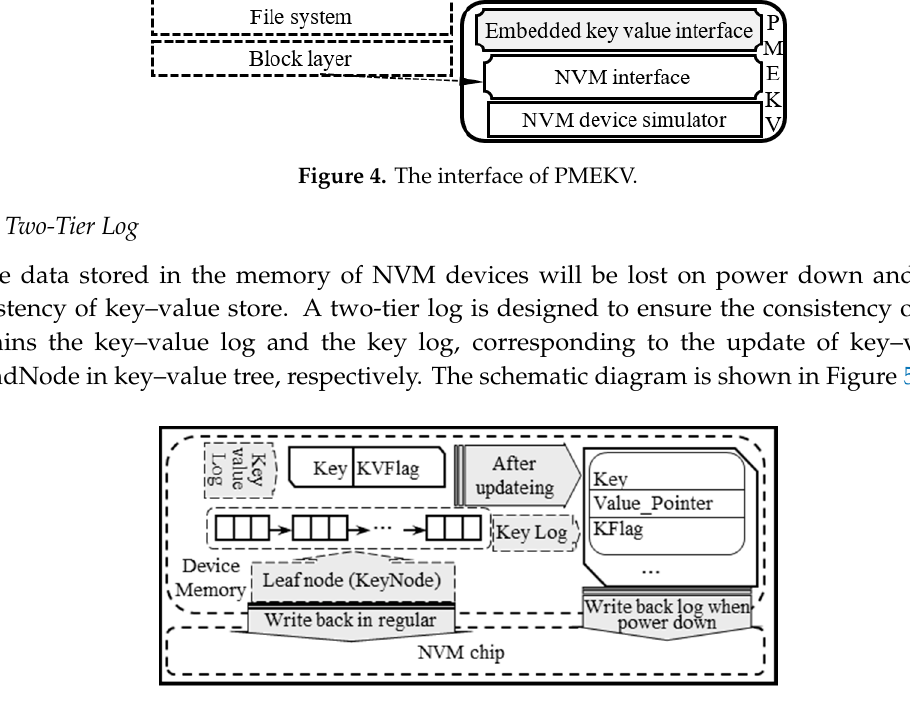
Figure 5. The schematic diagram of consistency strategy based on the two-tier log.